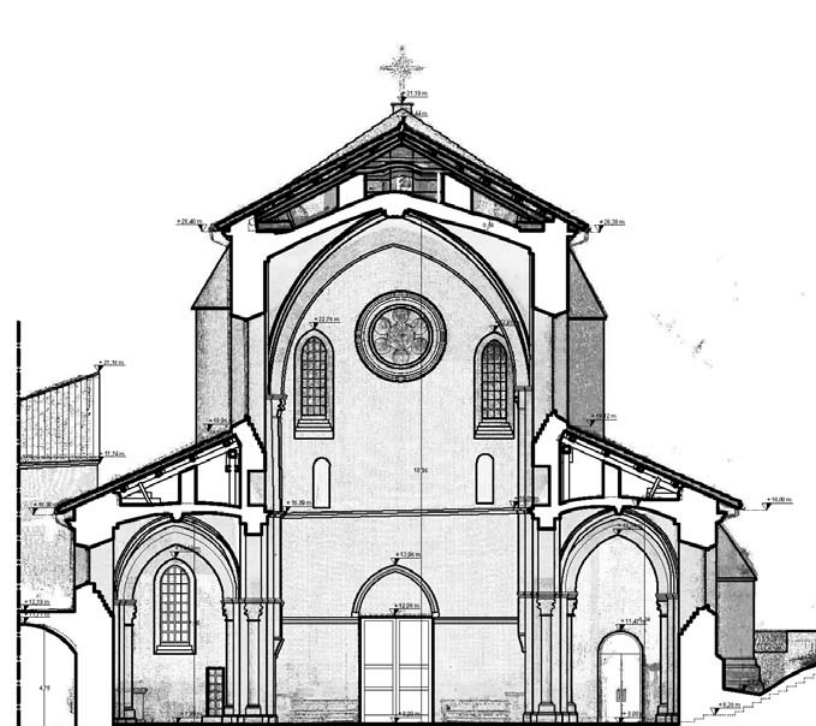
Figure 4b. Cross section, looking at the church